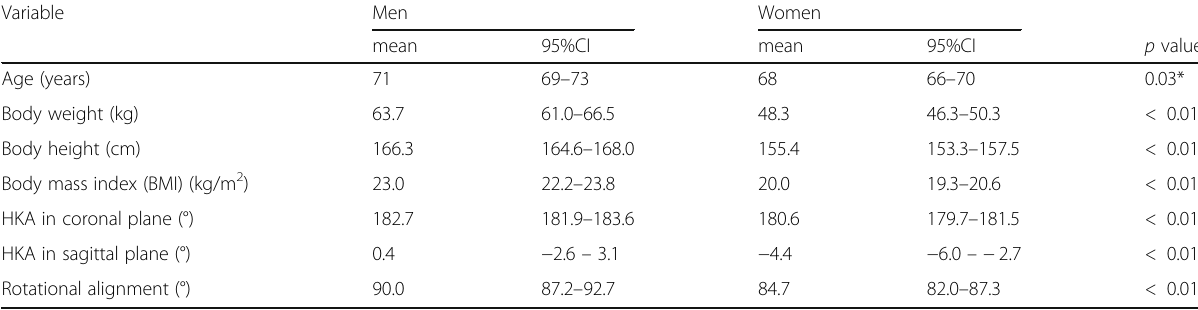
Table 1 Differences in each parameter between men and women Variable